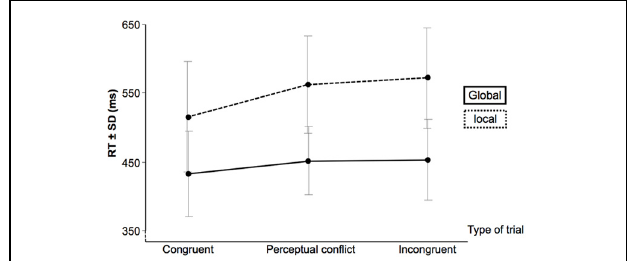
FIGURE 3 | Response time (RT) and standard deviation (SD) for correct